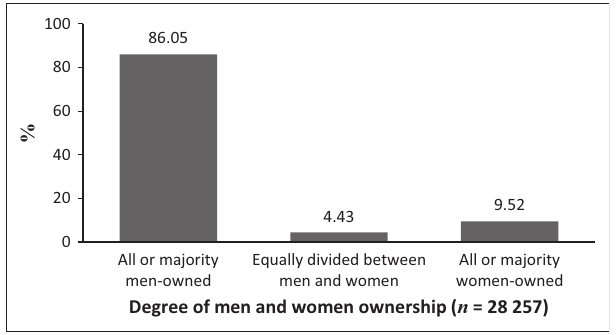
FIGURE 2: Gender composition of firms’